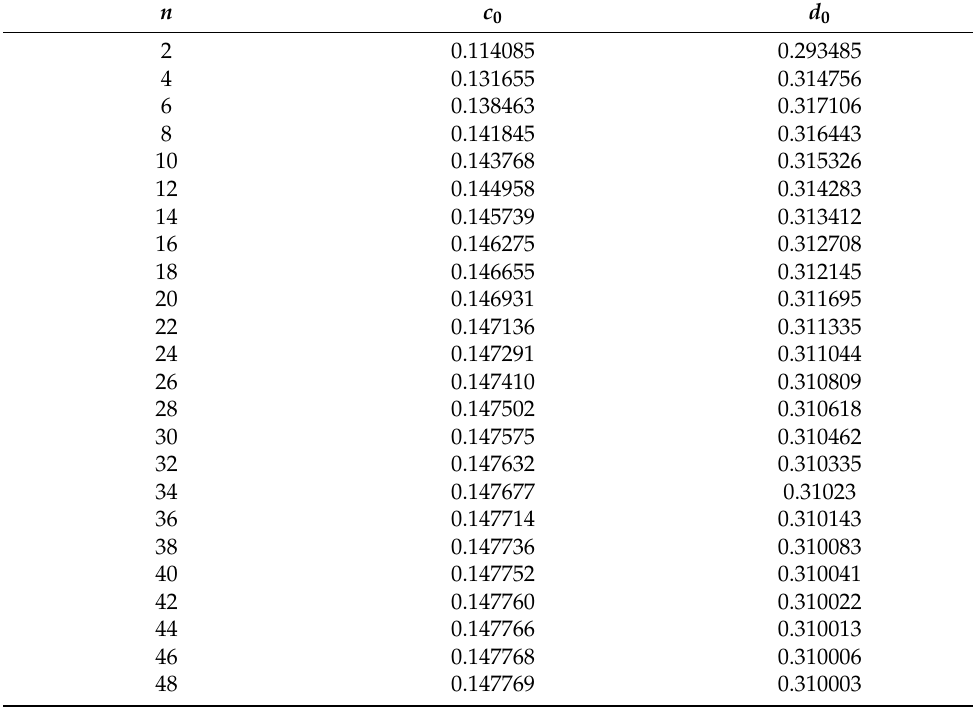
Table 1. Numerical values of c 0 and d 0 at different n when gas pressure q = 0.003 MPa. n c